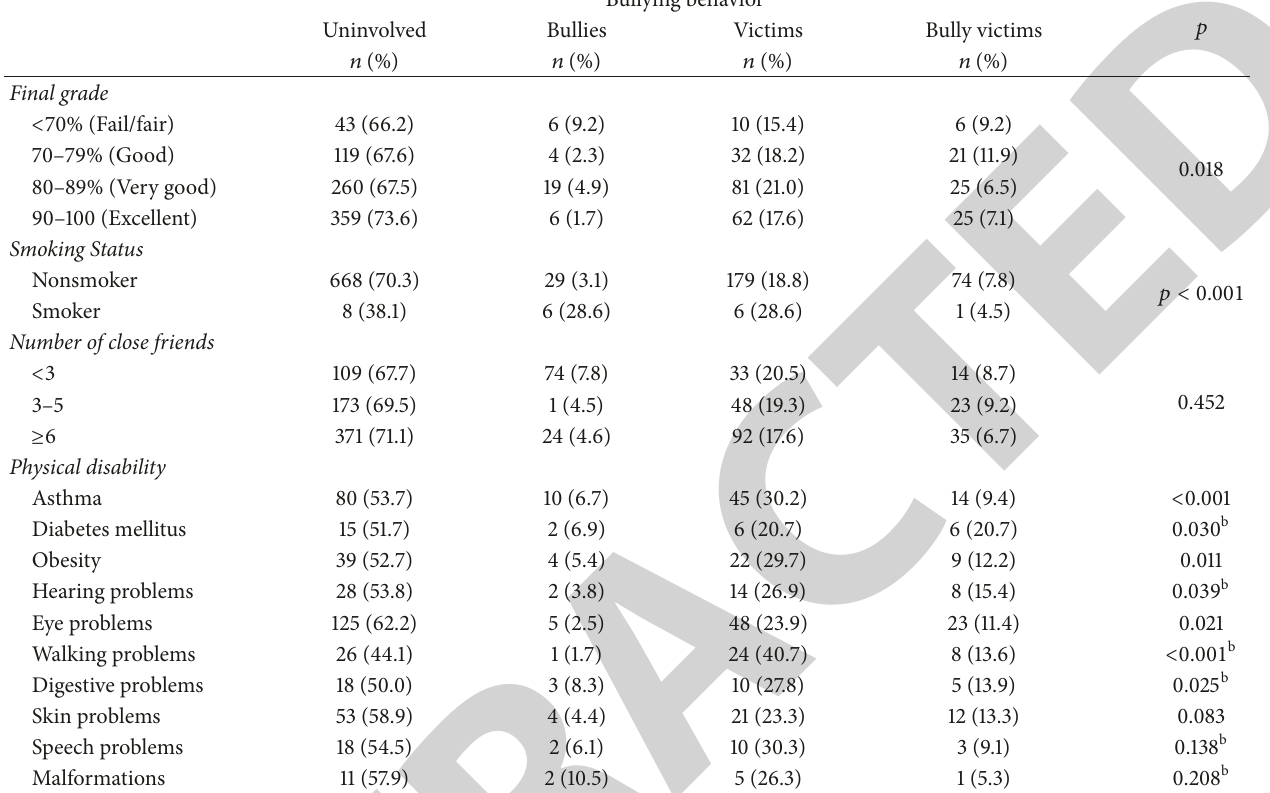
Bullying behavior